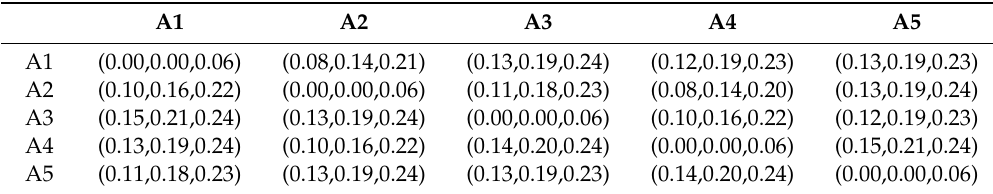
Table 6. The normalized fuzzy directed-relation matrix ˜ Z .